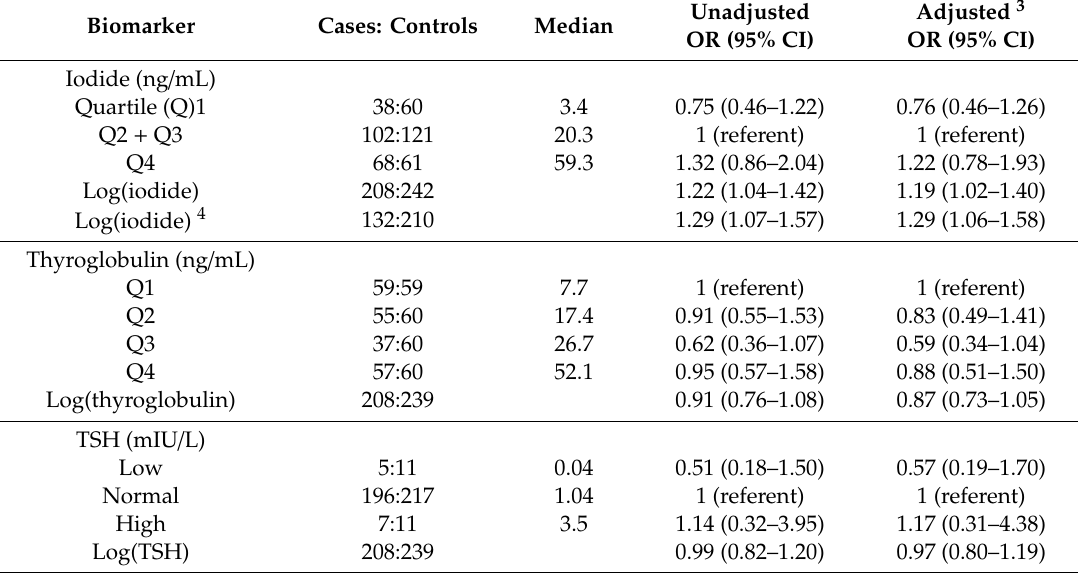
Table 2. Unadjusted and adjusted odds ratios (ORs) and 95% confidence intervals (CIs) for preterm birth according to maternal serum iodide, thyroglobulin, and thyroid stimulating hormone in the Finnish Maternity Cohort and Maternal Birth Register, 2012–2013 1,2